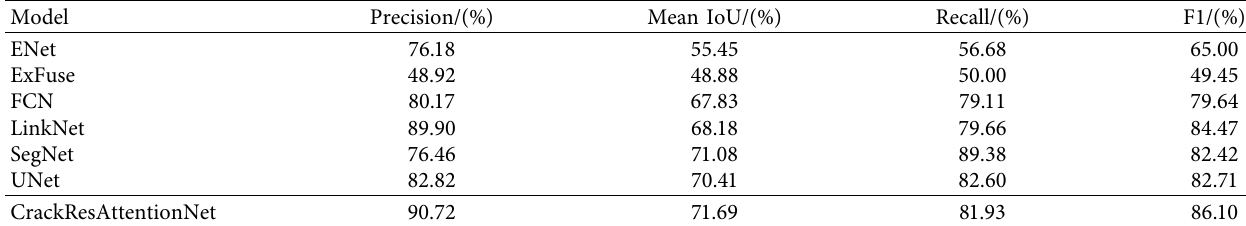
Table 5: Public Crack Dataset- Dice loss.